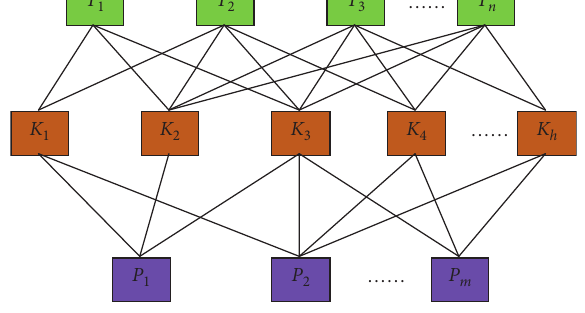
Figure 2: The T-K-P network. Table 2: The fuzzy evaluation sets of satisfaction degree of knowledge.